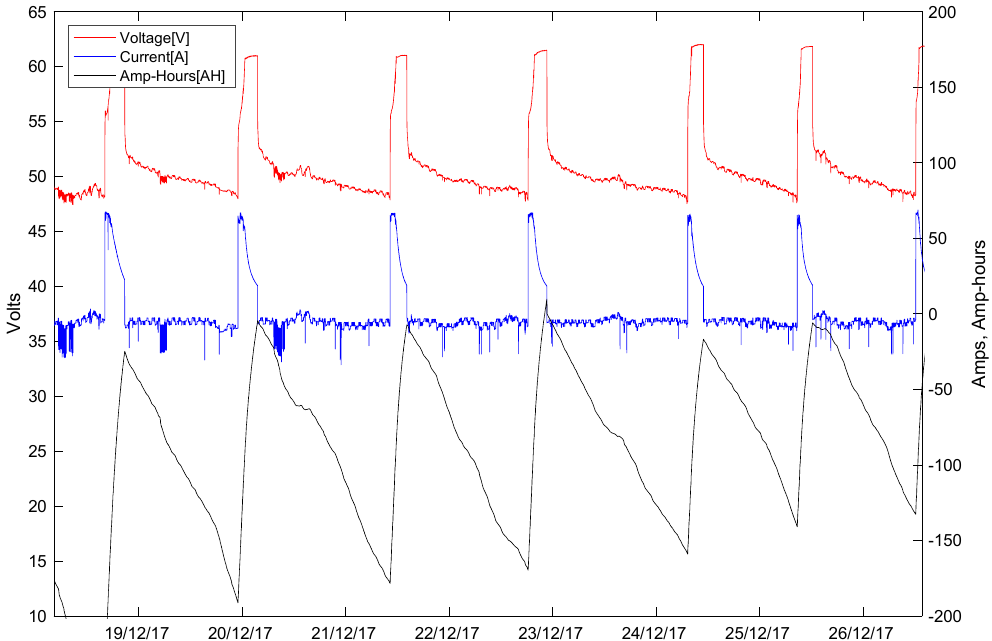
Figure 6. No solar PV input due to snow cover and system is relying purely on genset-based PSoC charge cycling. Genset automatically starts when V < 47.5 and stops when V > 57.6 & I < 20 A. Cycle-by cycle reduction in capacity is easily observed due to incomplete charge reconciliation.